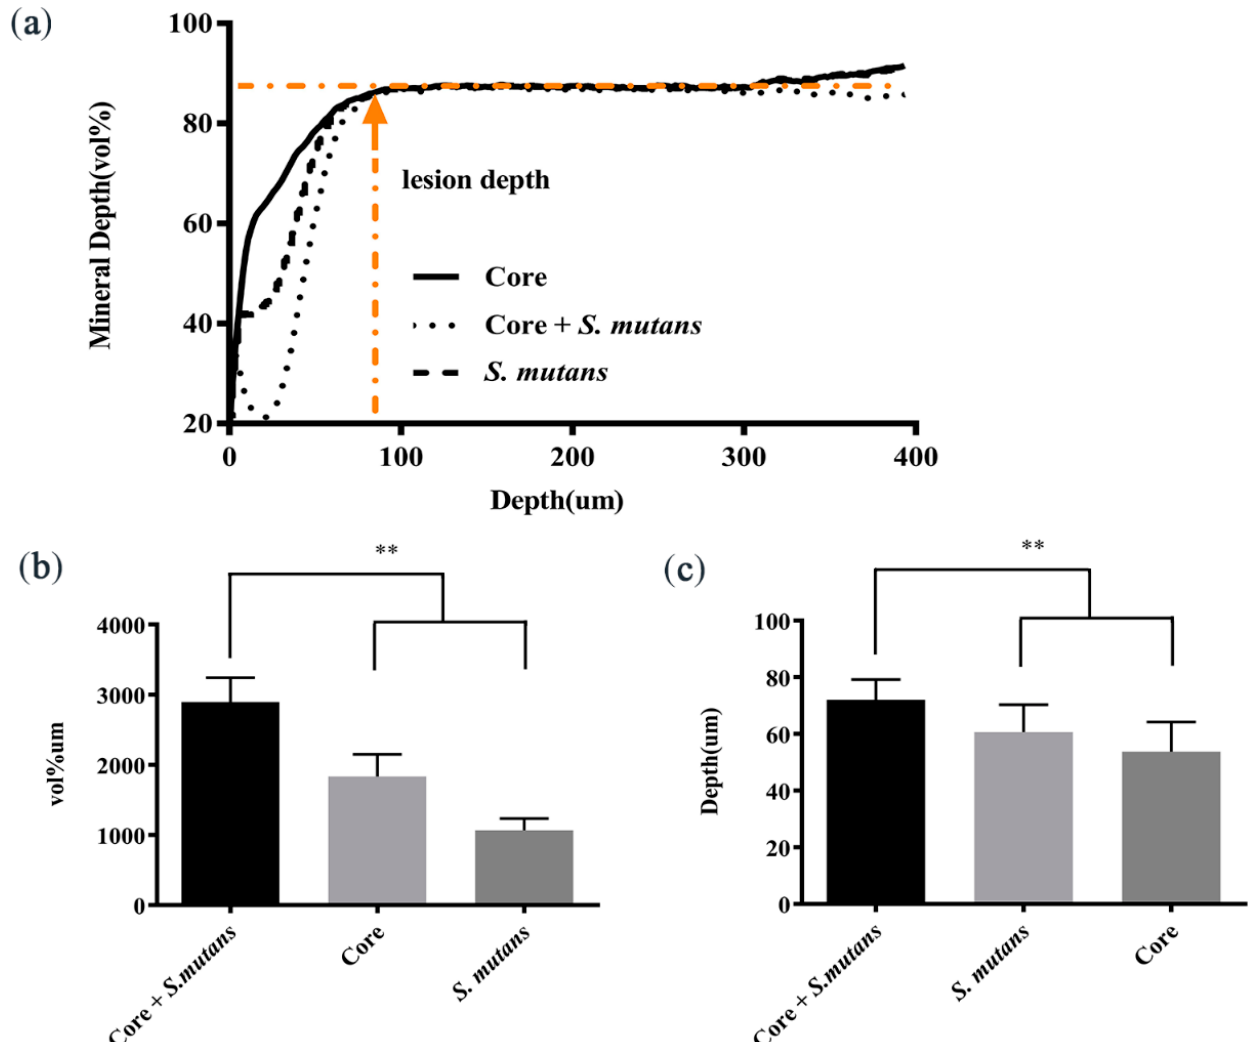
Figure 3. Enamel demineralization ability of the biofilms (n = 3). ( a ) Demineralization of the 72 h biofilm treated enamel slides. ( b ) Quantification of the integrated mineral loss. ( c ) Quantification of the demineralized depth. ** p < 0.01.